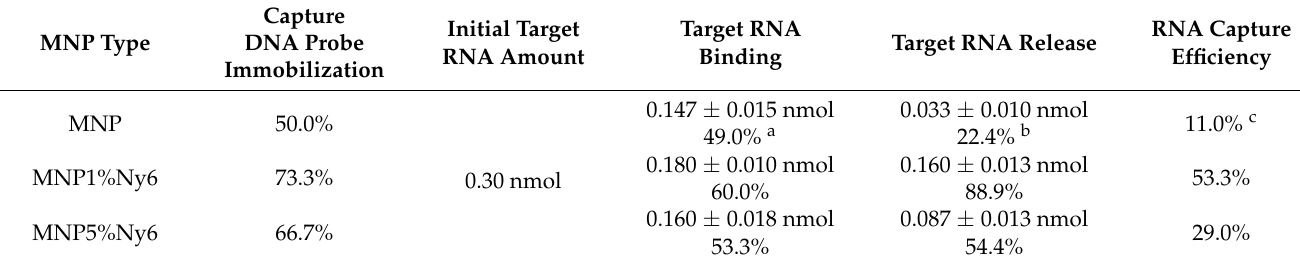
Table 3. MNP nanocomposites